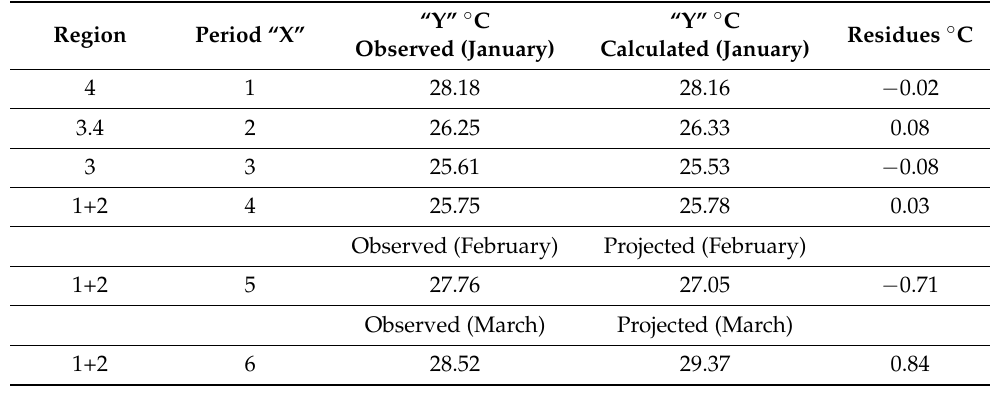
Table 3. Observed data for the month of January and the projected value for zone 1 + 2 (months February and March).